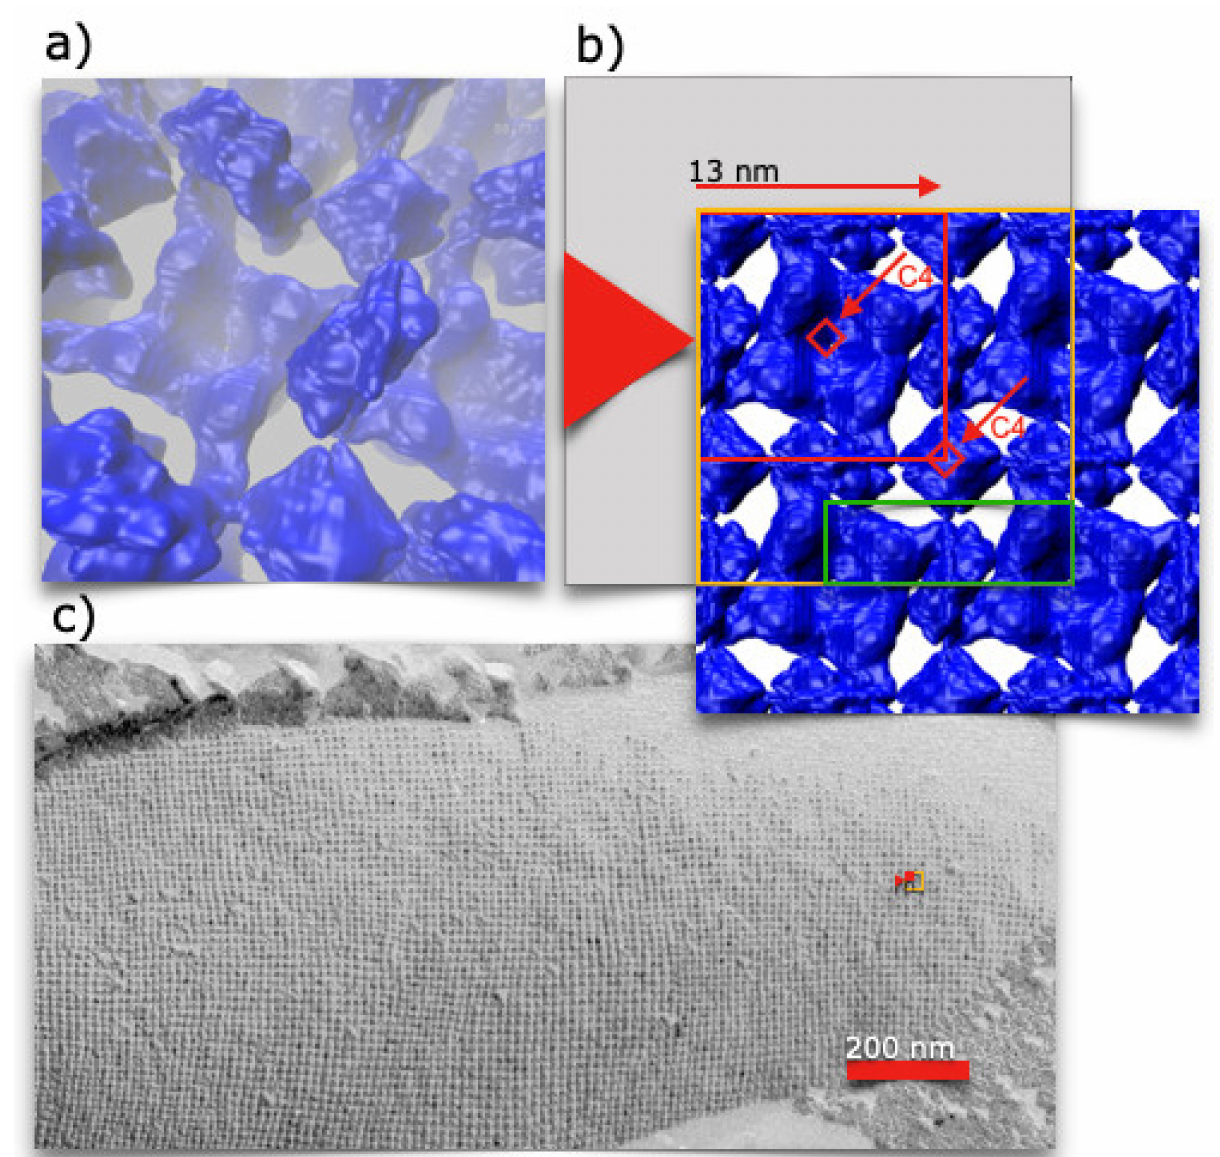
Figure 1. ( a ) 3D rendered cryo-TEM image of SbpA the S-layer protein of Lysinibacillus sphaericus ATCC 4525 [9] seen from outside the cell. The S-layer shows square (p4) lattice symmetry. ( b ) The red square marks the primitive unit cell. The yellow square indicates the model cell and the green rectangle marks the simulation box used in the fluid dynamic simulations. The four-fold symmetry (rotation) axis is drawn as a red upright square. ( c ) TEM image of a freeze-etched and metal shadowed preparation of a bacterial cell. The S-layer, which is the outermost cell envelope component, shows square lattice